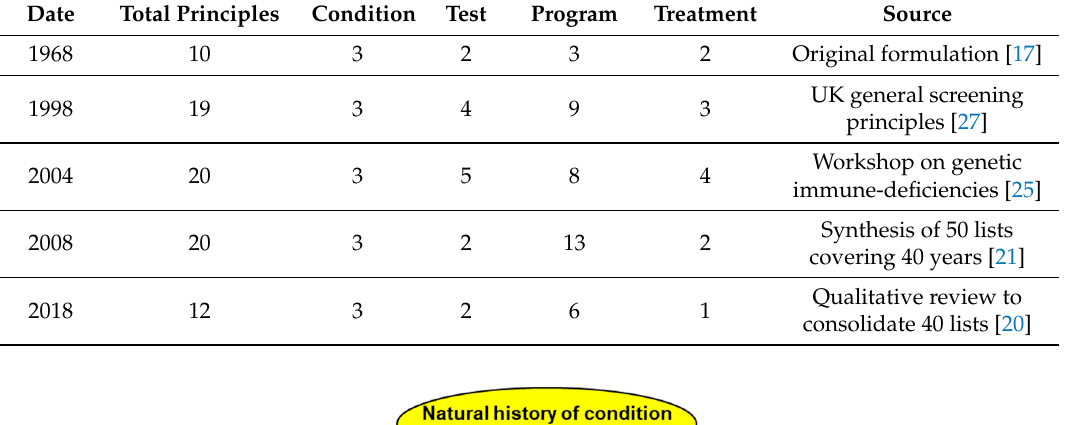
Table 1. The changing numbers of population screening criteria 1968–2018, in groups from [17] showing adaptations to specific situations while validating the original approach.